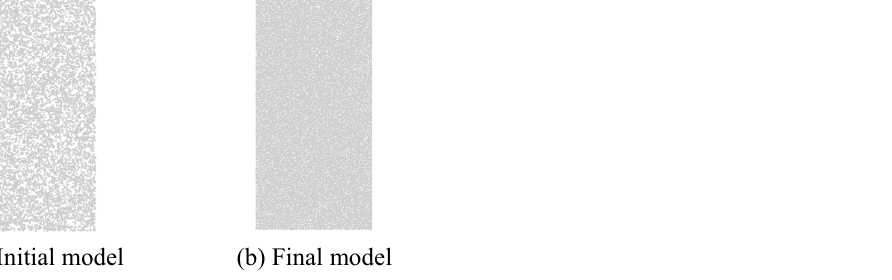
Figure 4. The PFC numerical